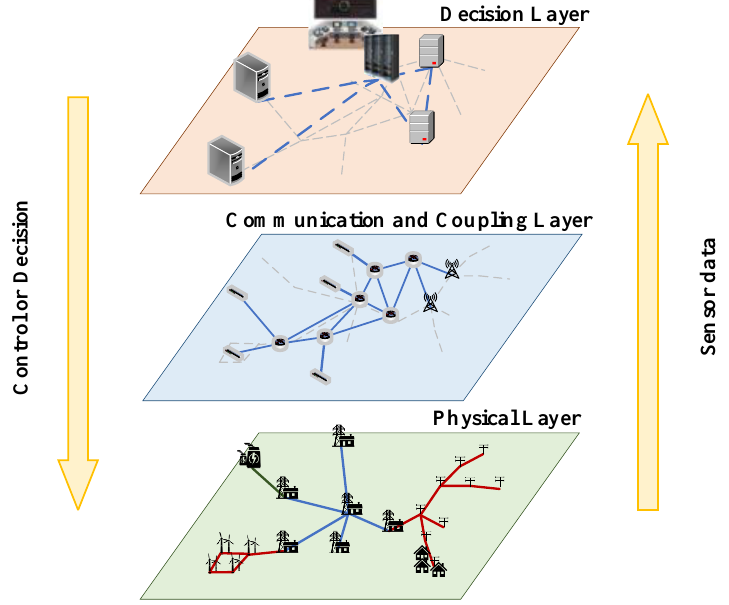
Figure 1. The structure of the distribution network CPS.